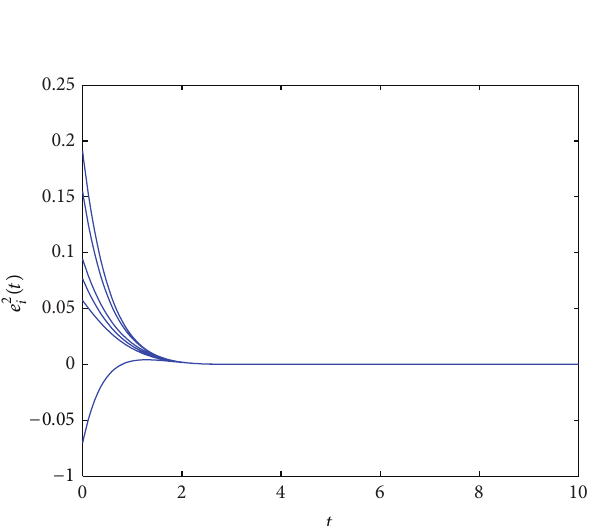
Figure 1: Error variable 𝑒 1 𝑖 (𝑡) (𝑖 = 1,2,...,6) of system (39) with 𝑘 = 1 .